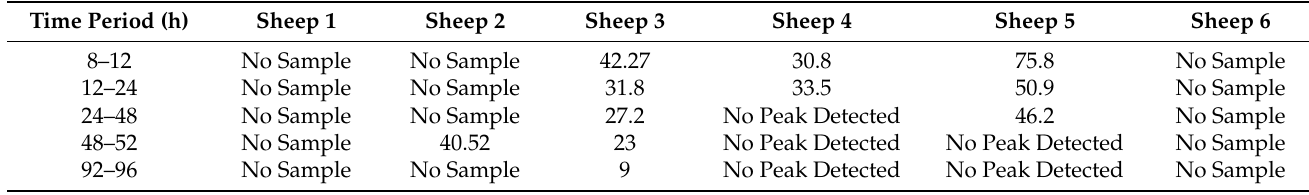
Table 2. Interstitial fluid meloxicam concentrations (ng/mL) following subcutaneous administration of 2 mg/kg sustained- release meloxicam formulation in sheep ( n = 6).